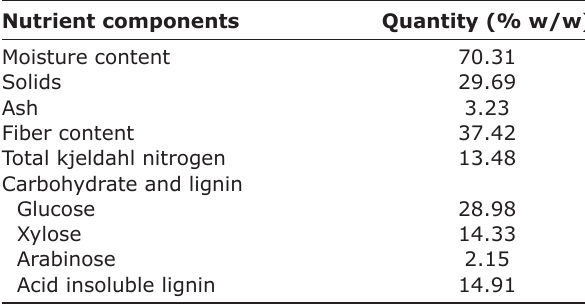
Table-1: Ingredient and chemical components of diet. Nutrient